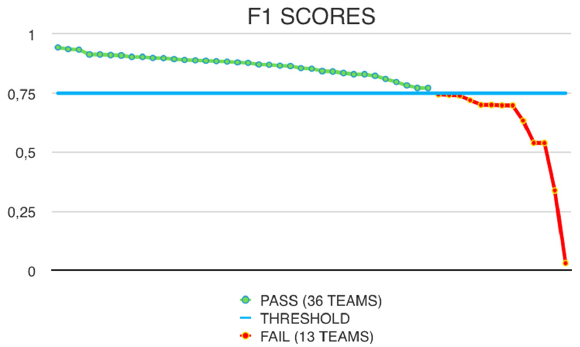
Figure 4. The F1 scores for 49